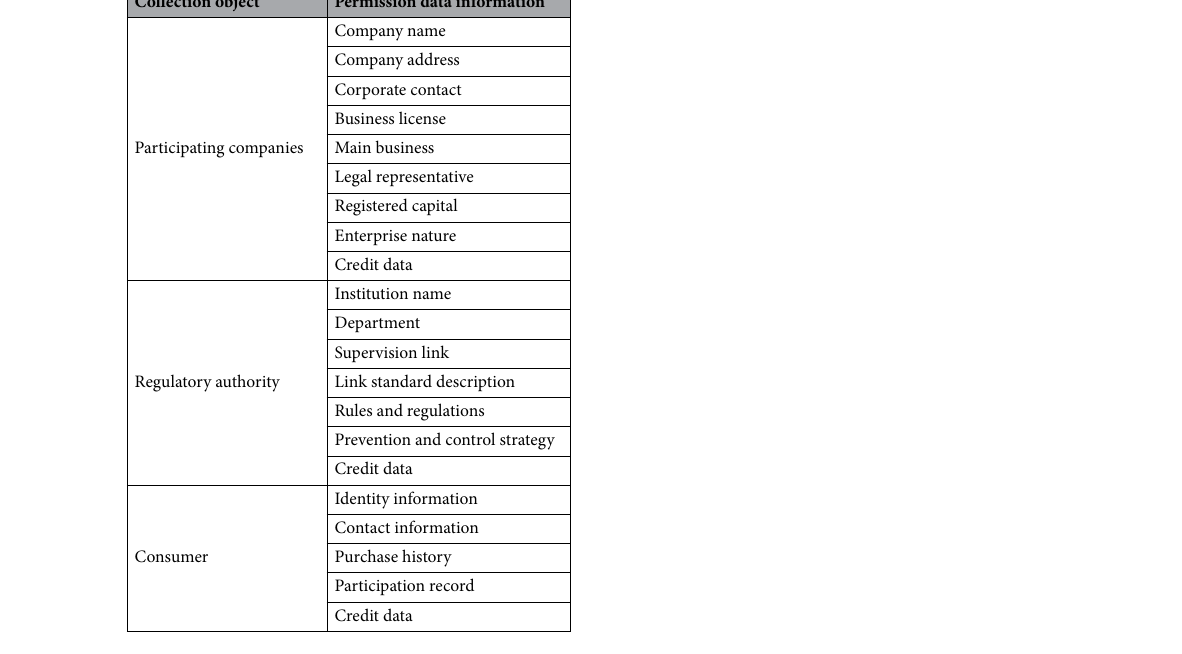
Table 3. Permission data collection